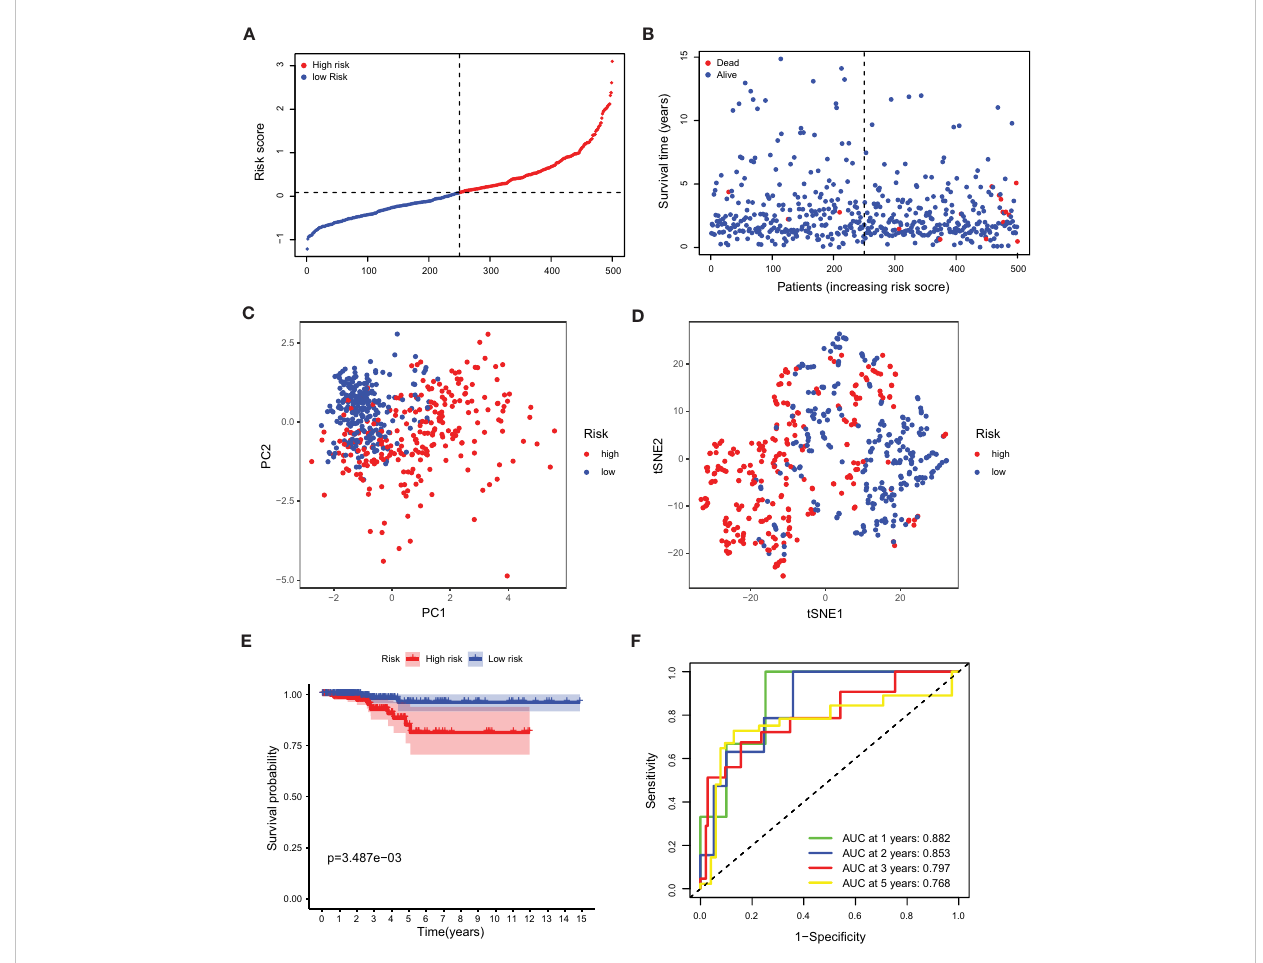
FIGURE 3 Prognostic analysis of the 5-gene signature model. (A) The distribution and median value of the risk scores. (B) The distributions of OS status, OS and risk score. (C) PCA analysis of the TCGA cohort. (D) t-SNE analysis of the TCGA cohort. (E) Kaplan-Meier curves of the OS in the two groups. (F) AUC of time-dependent ROC curves evaluated the prognostic capacity of the risk